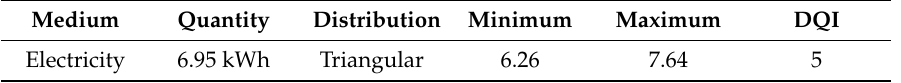
Table 3. Sample electricity test results specified for the preform stretching and extending